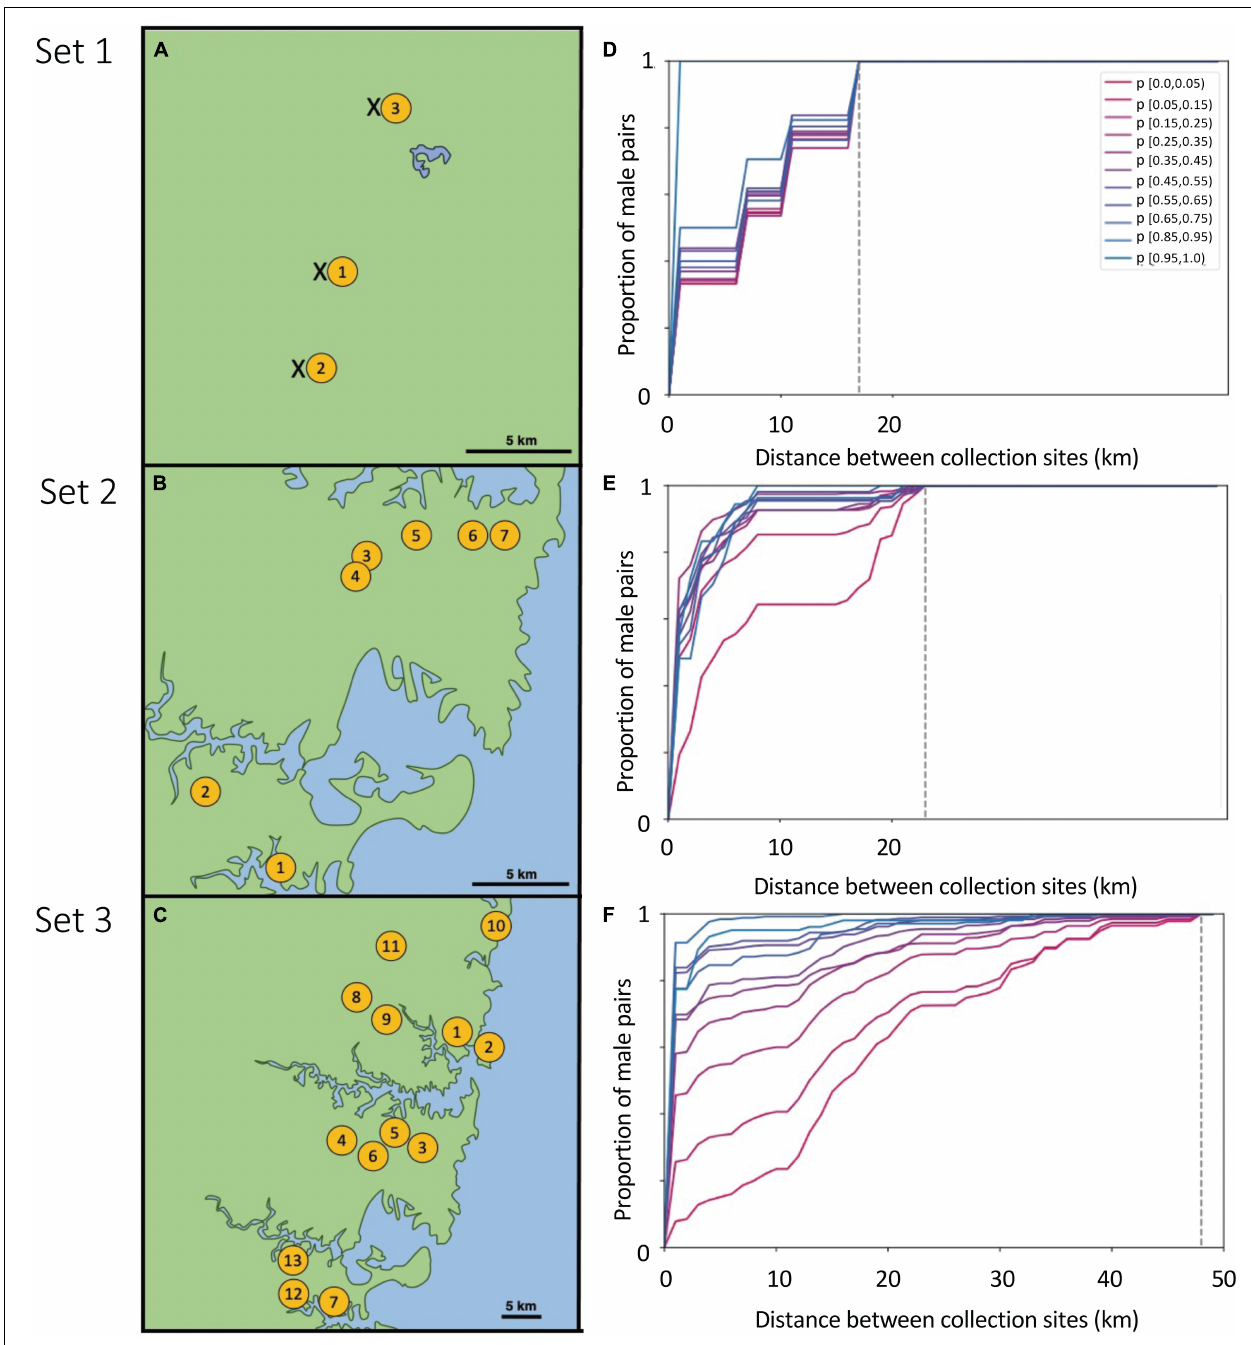
FIGURE 1 | Left: Sites (yellow circles) at which T. carbonaria male aggregations were successfully attracted using “bait” re-queening colonies in hives for each of three sample sets: (A) Set 1 (Sunshine Coast), (B) Set 2 (Sydney), (C) Set 3 (Greater Sydney). In Set 1, we also sampled from hived colonies at each site (“x”). Right: The cumulative distribution plots of the distance between pairs of males binned by their probability of sibship ( p ), for males collected in each of the three Sets 1–3 (D–F) . High p -values for sibship (blue) indicate pairs of males that are likely to be brothers, while low p -values (pink) indicate pairs of males that are not related. Distances of zero indicate pairs of males in the same aggregation, while distances > 0 indicate males were sampled from different aggregations at that distance (km). Dotted lines indicate the maximum possible distance separating male pairs for each Set (i.e., the distance spanning the two furthest apart aggregations sampled in that set; 15, 23, and 48 km for sets 1–3, respectively). These cumulative distribution plots served as the observed data against which our simulated sibship data was compared, to estimate best-fit male dispersal distributions.